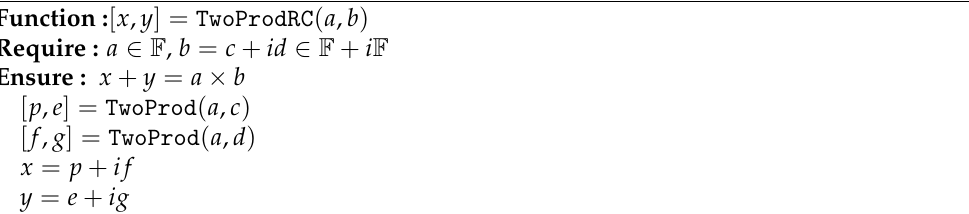
Algorithm 2 Error-free transformation of the product of real and complex floating-point